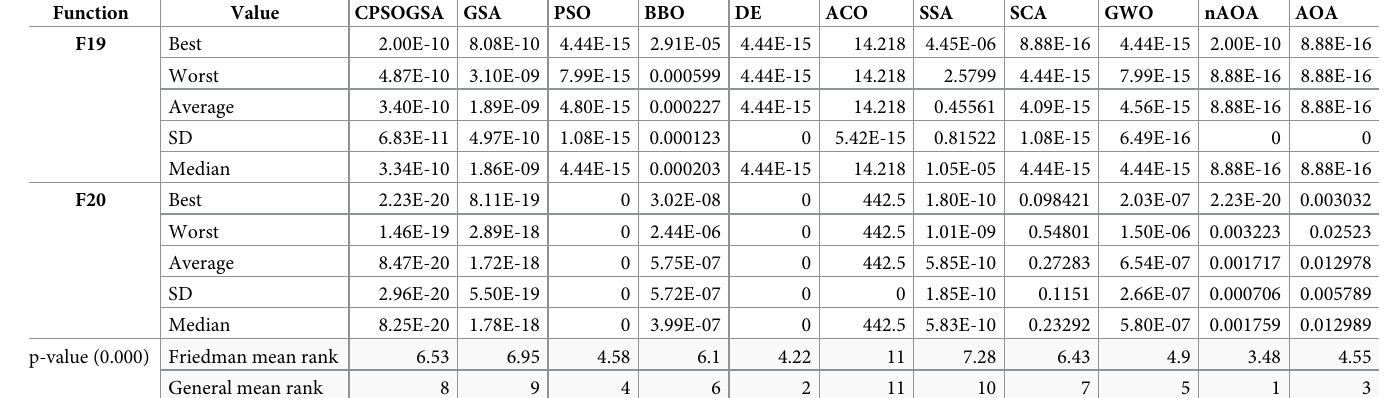
implemented in MATLAB R2020b; they were run on Windows 10 OS, Intel Core i7- the number of independent runs was set at 30. The source codes are publicly available in the respective references. For a fair comparison, all the algorithms were executed using 1000 itera- tions and population size of 50. The results for each engineering problem are presented using five (5) performance indicators: namely, best, worst, average, standard deviation (SD), and median. In addition, the algorithms are compared using mean, standard deviation, and Wil- coxon signed-rank test. 4.2.1. The welded beam design problem. The welded beam design problem is a minimi- zation problem, in which we used nAOA along with 10 other algorithms to reduce the manufacturing cost of the design [27]. Fig 6 gives an illustration of the WBD. The WBD con- straints are shear ( τ ) and beam blending ( θ ) stress, bar buckling load ( P ( δ ), and side constraints. The design variables for WBD are: